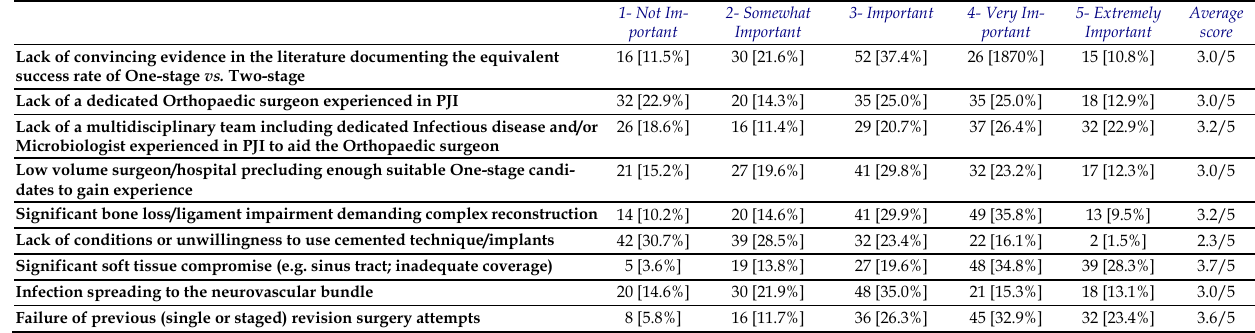
Table 4A. Delegates voting on importance of several factors in their choice for Two-stage and NOT One-stage